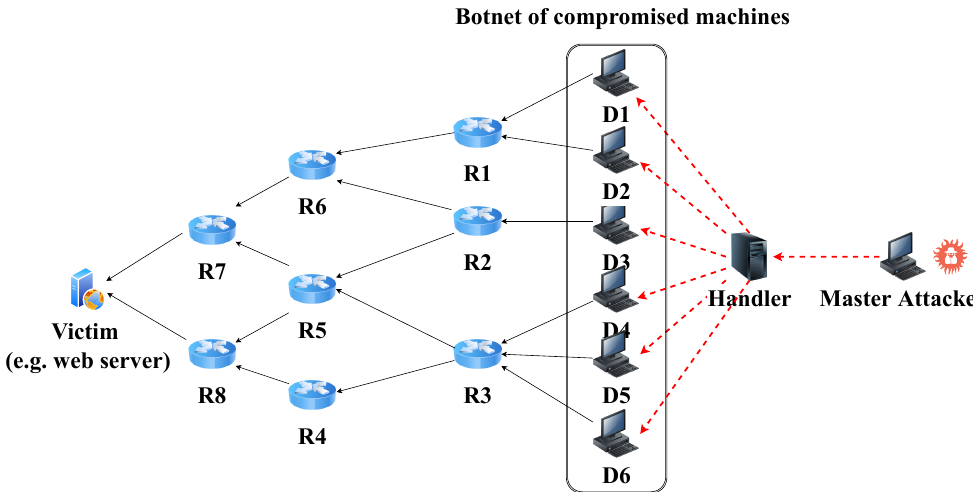
Figure 2. Potential DDoS attacks from six different daemons targeting the same